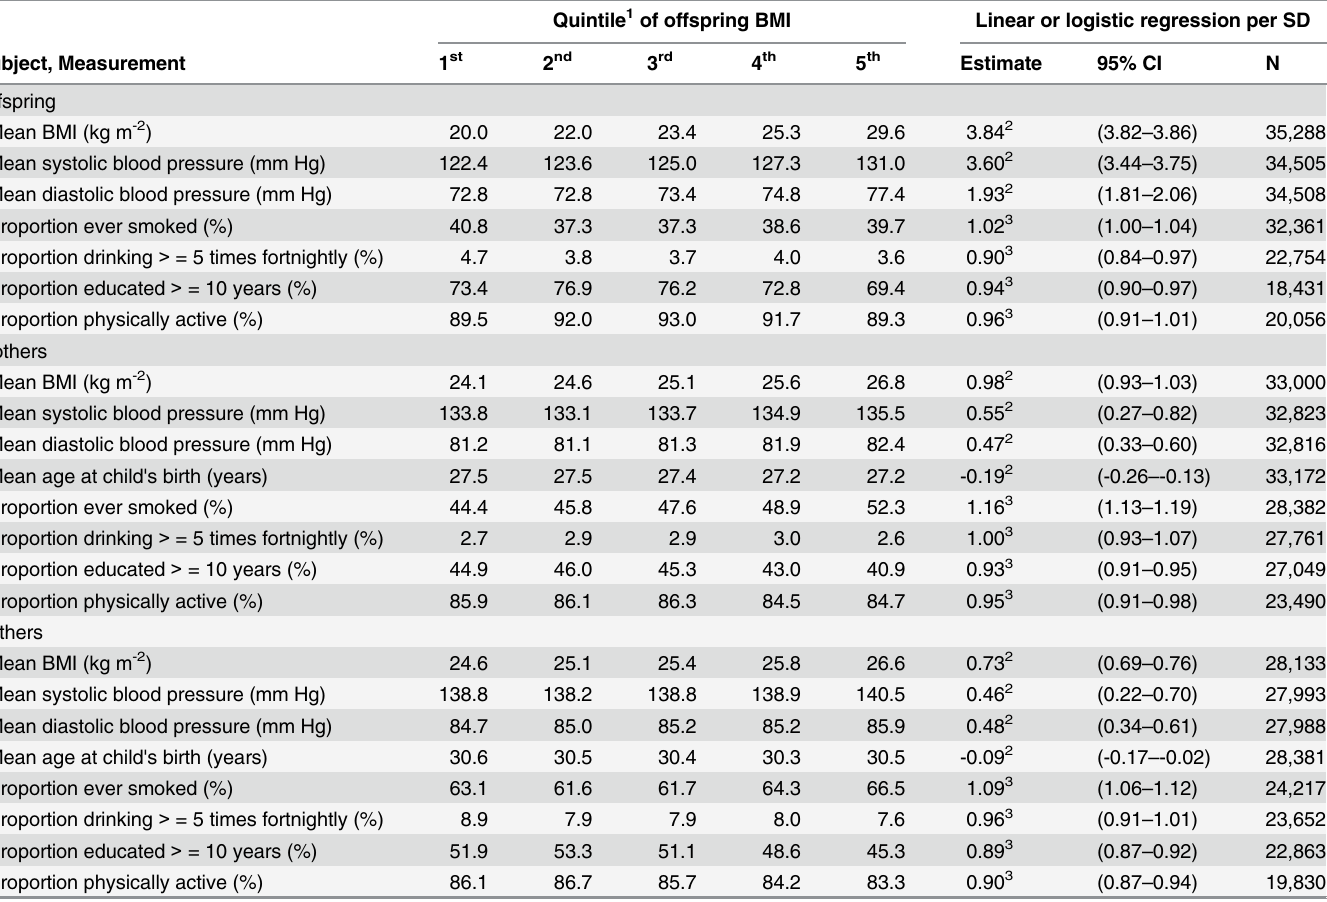
Table 1. Characteristics of parents and offspring according to quintiles of offspring body mass index. Quintile 1 of offspring BMI Linear or logistic regression per